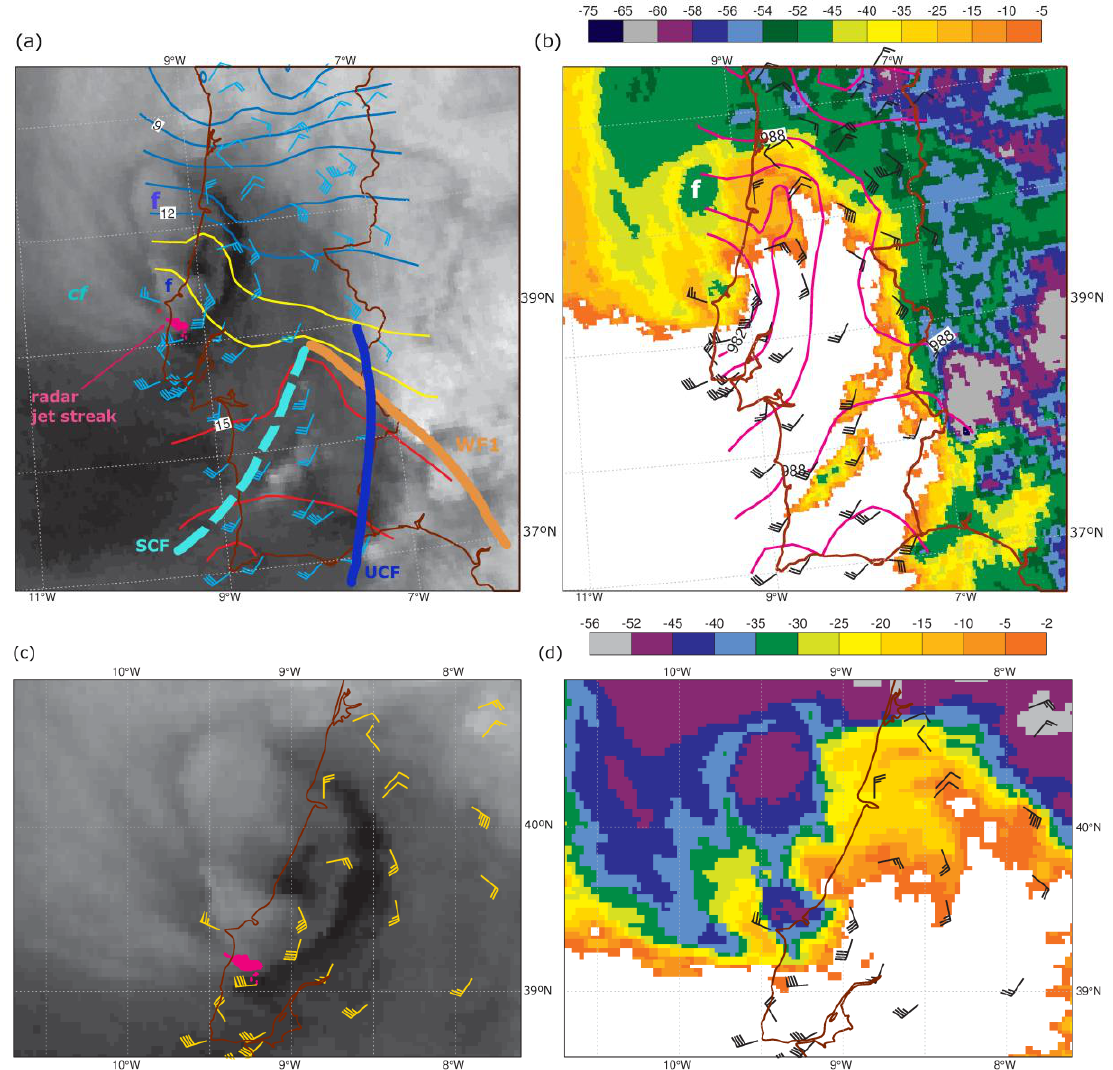
Figure 15. ( a ) MSG WV6.2 image superimposed with observations of surface θ w (1 ◦ C intervals, from 8 to 12 ◦ C in blue, 13 and 14 ◦ C in red lines and ≥ 15 ◦ C in red lines) and wind gust at 10 m (barbs); ( b ) IR10.8 brightness temperature (shaded from − 5 to − 75 ◦ C) superimposed with observations of MSLP (2 hPa intervals, magenta lines) and wind gust at 10 m (barbs) at 04:40 UTC. The low-level jet streak detected by radar and the major cloud filaments (cf and f) are marked in ( a ). The WF1 (orange line), SCF (dashed cyan line) and UCF (blue line) are also marked in ( a ). ( c ) zoom-in of MSG WV6.2 image superimposed with wind gust at 10 m (yellow barbs) and the low-level jet streak. ( d ) zoom-in of IR10.8 brightness temperature (shaded from − 2 to − 56 ◦ C) superimposed wind gust at 10 m (black barbs).